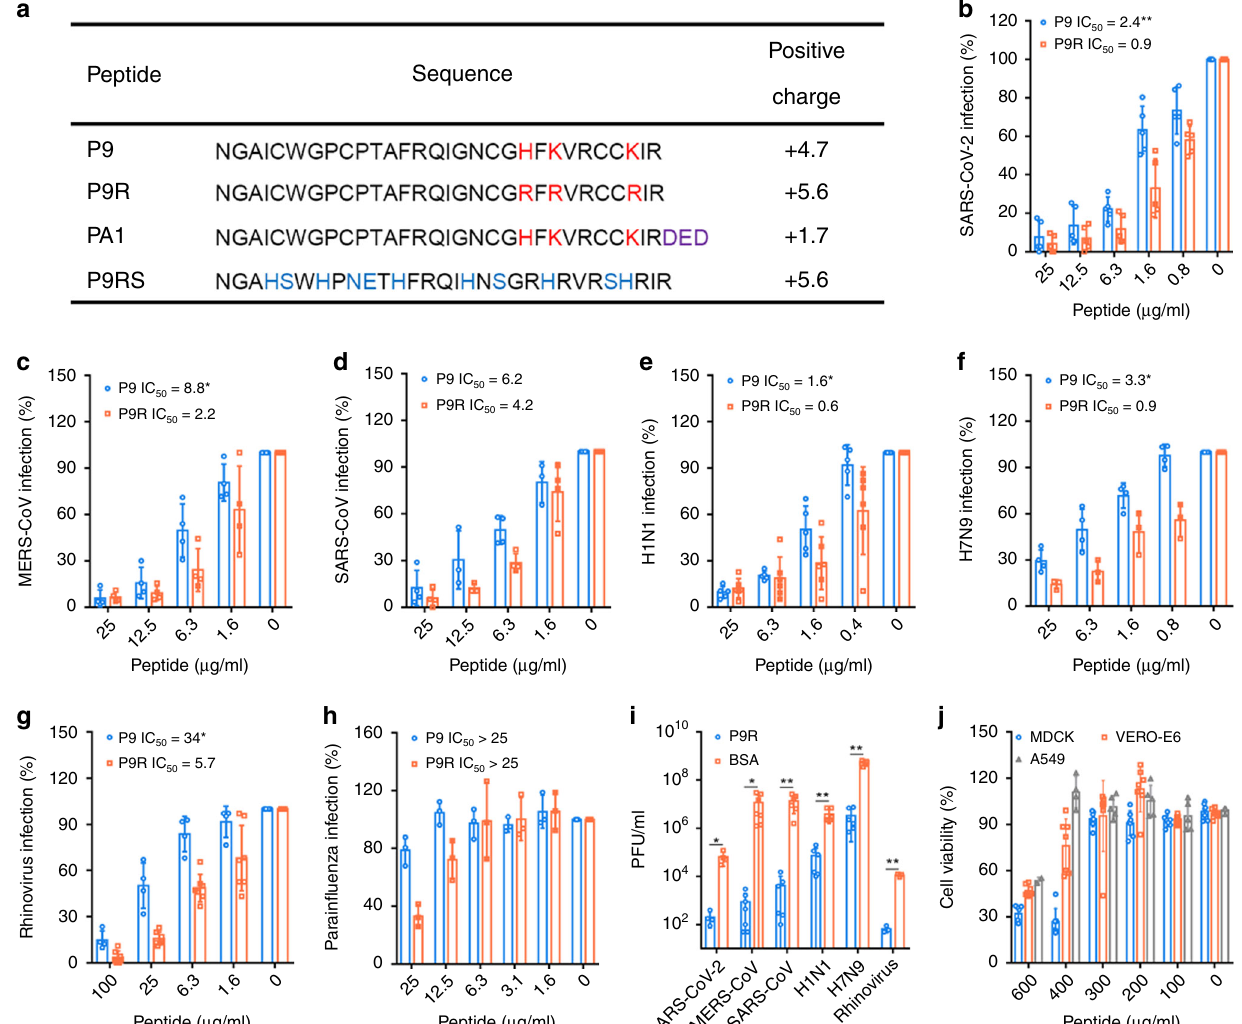
Fig. 1 P9R could broadly inhibit enveloped and non-enveloped virus replication. a Peptide sequences and positive charge analyzed by PepCalc of InnovaGen. The net positive charges of peptides are related to pH 7.0. b – h P9R could inhibit viral replication of SARS-CoV-2 ( n = 5), MERS-CoV ( n = 4), SARS-CoV ( n = 4), H1N1 virus ( n = 5), H7N9 virus ( n = 4), rhinovirus ( n = 4), but not parain fl uenza 3 virus ( n = 3) in cells. Viruses were premixed with different concentrations of P9R or P9 and then infected cells. The antiviral ef fi ciency was evaluated by plaque reduction assay. Infection (%) was calculated by the plaque number of virus treated with peptides divided by the plaque number of virus treated by BSA. P = 0.006 for SARS-CoV-2, P = 0.042 for MERS-CoV, P = 0.02 for H1N1 virus, P = 0.03 for H7N9 virus, and P = 0.007 for rhinovirus when IC 50 of P9R against virus was compared with that of P9. i The potent antiviral activities of P9R against viruses including SARS-CoV-2 ( n = 4, P = 0.015), MERS-CoV ( n = 7, P = 0.027), SARS-CoV ( n = 6, P = 0.005), H1N1 (n = 6, P = 0.002), H7N9 ( n = 6, P < 0.001) and rhinovirus ( n = 3, P < 0.001) by measuring the viral titers in supernatants at 24 h post infection when viruses were treated by P9R or BSA (50 – 100 μ g ml − 1 ). Asterisk indicates P < 0.05 and double asterisk indicates P < 0.01 when compared with virus treated by BSA. P values were calculated by the two-tailed Student ’ s t test. j Cytotoxicity of P9R in MDCK ( n = 7), VERO-E6 ( n = 7) and A549 ( n = 5) cells. Data are presented as mean ± SD of at least three independent experiments. Source data are provided as a Source data fi